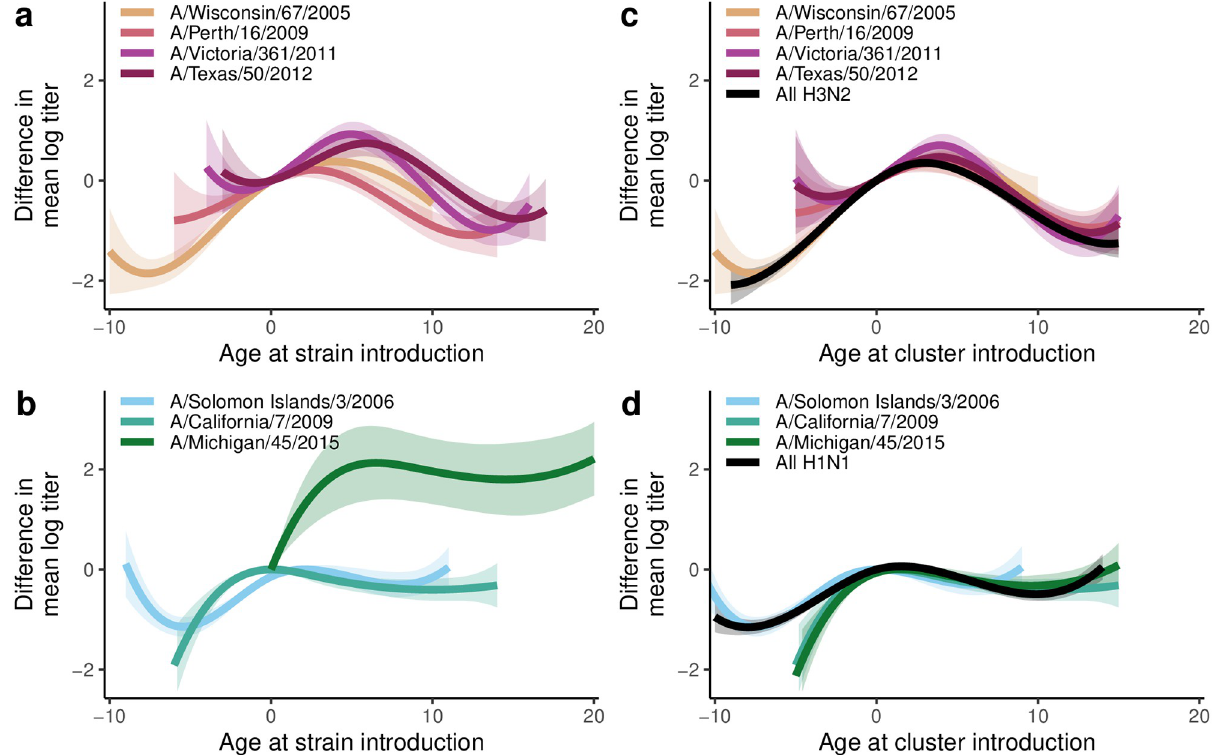
Fig 5. Cohort effects on HAI titers. a) Difference in mean log titer in the H3N2 strain-specific models by age at strain introduction. b) Difference in mean log titer in the H1N1 strain-specific models by age at strain introduction (note: for A/Michigan/45/2015 we linearly impute the effect to age 0). c) Difference in mean log titer in the H3N2 strain-specific models and the H3N2 subtype model by age at antigenic cluster introduction. d) Difference in mean log titer in the H1N1 strain-specific models and the H1N1pdm model by age at antigenic cluster introduction. In each plot, the difference in mean log titer is relative to age 0 at strain or cluster introduction, and the bands give the 95% confidence intervals.